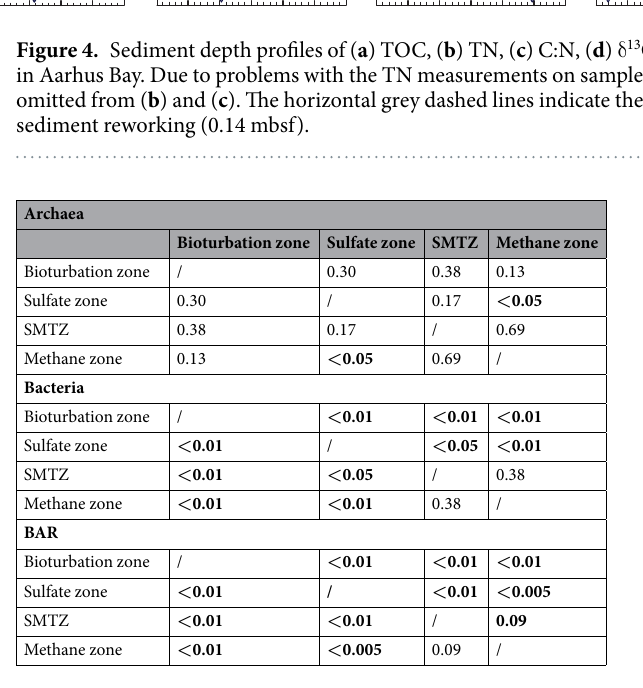
Table 1. Comparison of bacterial and archaeal 16S gene abundances and BARs across four biogeochemical zones based on Kruskal-Wallis tests with Mann-Whitney post-hoc tests. Statistically significant p-values are shown in bold. Only stations from which all 4 biogeochemical zones were reached by coring were included (M24, M26, M27A, M29A, M1 (2009), and